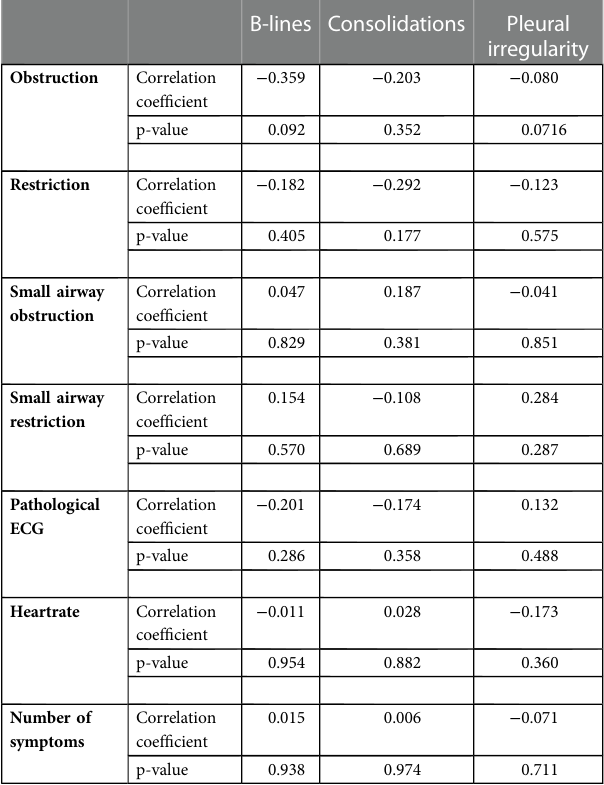
Table 4. Statistical correlation of clinical parameters with LUS